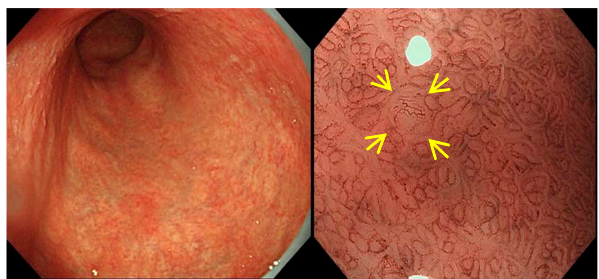
Figure 9. Images of white globe appearance with AIG.